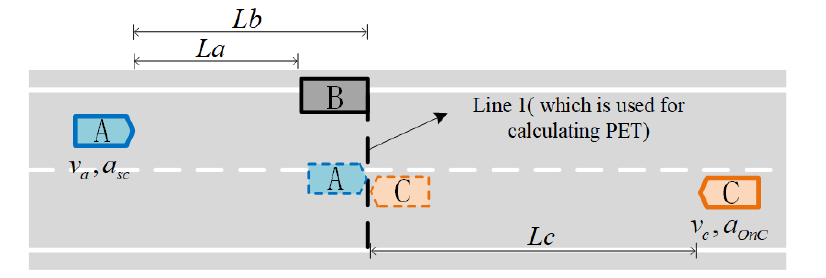
Figure 5. The site for calculating post-encroachment time.